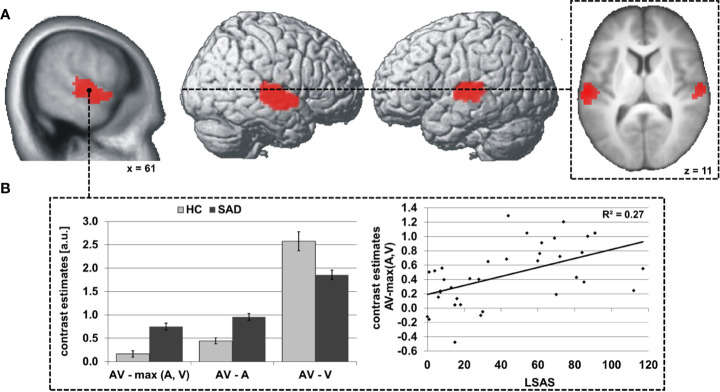
Differences in audiovisual face-voice-integration between SAD and HC rendered onto the lateral aspects of a standard brain as well as sagittal and transversal slices of the whole sample mean anatomy (A). Results shown at p < 0.05, cluster-size FWE-corrected for multiple comparisons across the whole brain at a voxel-wise threshold of p < 0.001. Coordinates refer to the MNI system. Voxel size 3 x 3 x 3 mm3. The diagrams (B) illustrate the underlying activation differences between audiovisual (AV), auditory (A) and visual (V) stimulation (left) as well as the correlation of the face-voice-integration effect with individual SA severity (LSAS, right). Light columns refer to HC and dark columns to SAD. Error bars indicate the standard error of the mean.